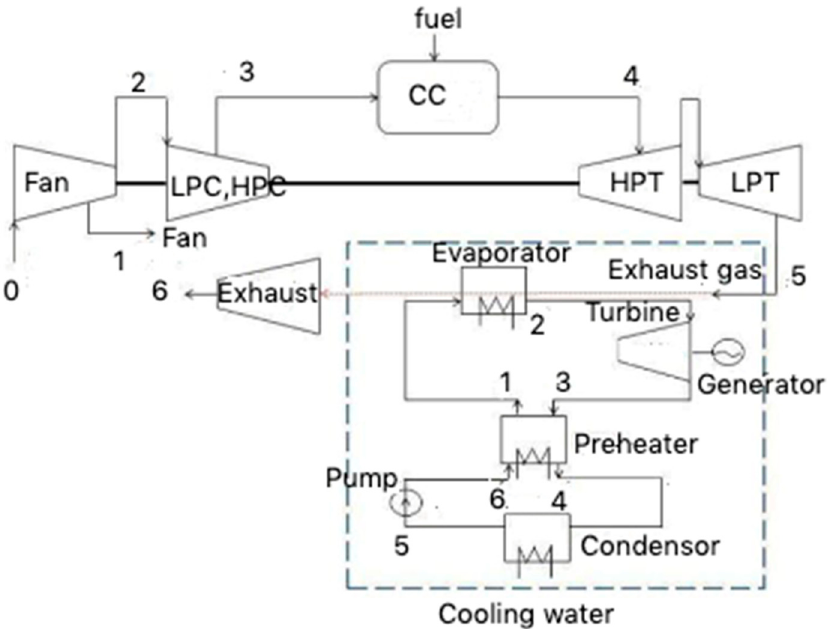
Figure 6. Schematic diagram for case A and case C.